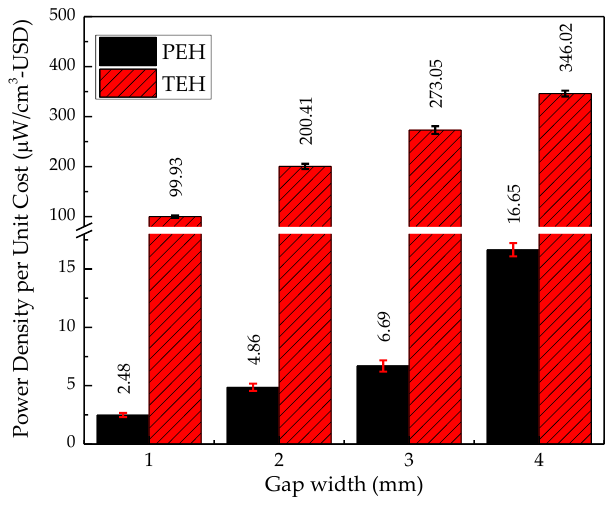
Figure 14. Power density per unit cost of PEH and TEH at a 4 mm gap width.